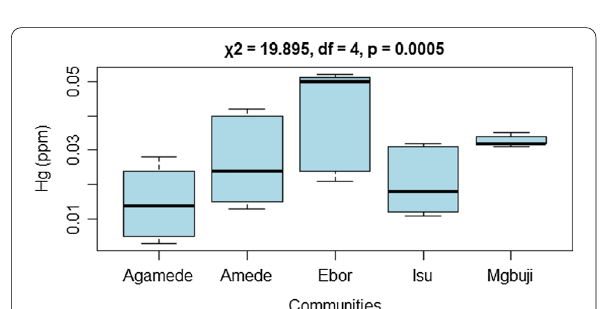
Fig. 5 Comparison of bioaccumulation of Hg in Achatina spp amongst sampled communities